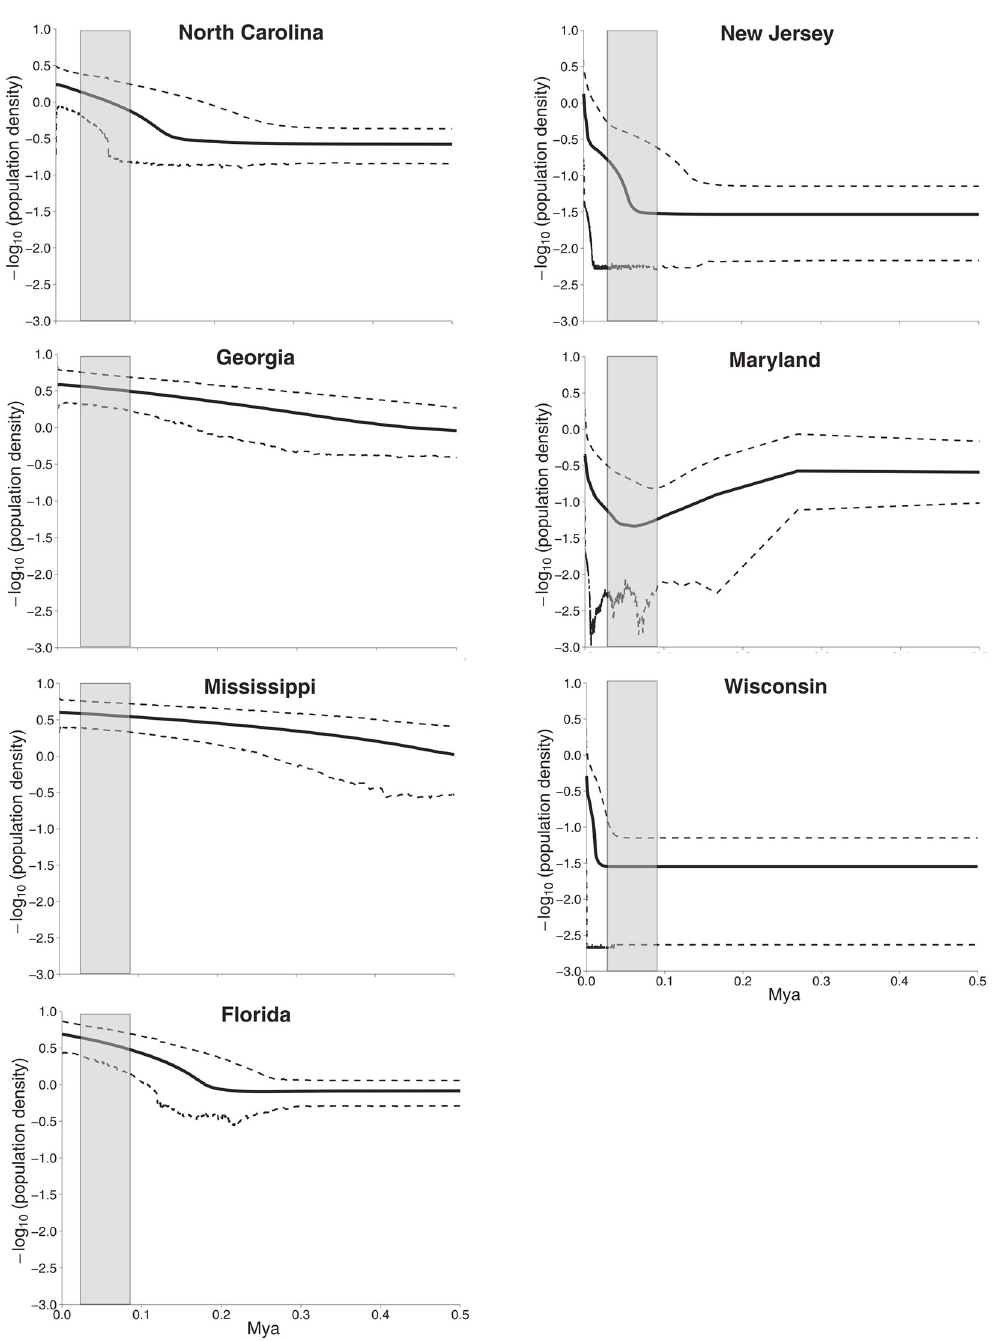
Fig 6. Extended Bayesian Skyline Plot (EBSP) analysis of population size changes over geological time estimated from all 9 loci. An EBSP was derived for each of the 7 collections which were then plotted on a single graph. 0.99, while C and D arise from clade B (PP = 0.99) that contains the remainder of the sequences. Most southern ticks arose in clade C (PP = 0.79) while only two southern ticks arose at the base (clade D) of the blue clade E (PP = 0.94). Northern ticks were monophyletic